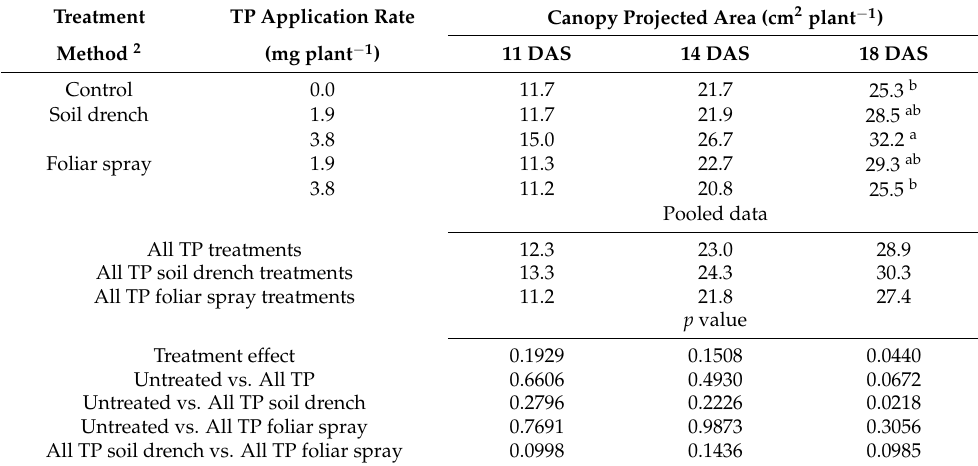
Figure 1. Overhead canopy images of soybean seedlings at 18 days after sowing: ( A ) color images; ( B ) binary images processed by ImageJ software. Tryptophan soil drench and foliar spray treatments were performed at 5 and 10 days after sowing (immediately after emergence and at the unifoliate leaf stage), respectively. The application volumes were 100 mL plant − 1 for soil drench treatments and 1 mL plant − 1 for foliar spray treatments. The control plants were sprayed with water (1 mL plant − 1 ) at 10 days after sowing. Table 1. Canopy projected area of soybean seedlings as affected by tryptophan (TP) soil drench and foliar spray treatments 1 .